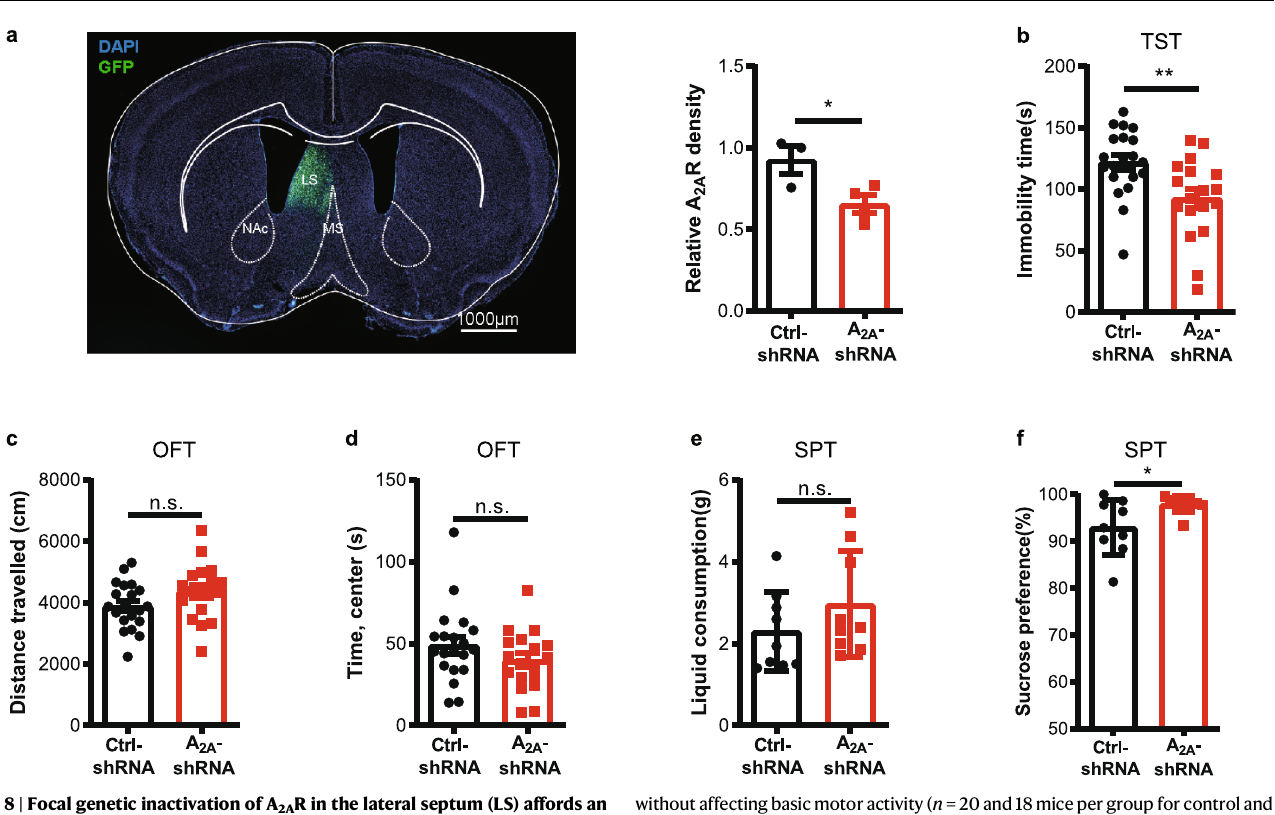
withoutaffectingbasicmotoractivity( n =20and18micepergroupforcontroland A 2A -shRNA, respectively. Unpaired t test, p =0.0860, t(36)=1.765) and time spent in the central area ( n =20 and 18 mice per group for control and A 2A -shRNA, respectively. Mann – Whitney test, p =0.1645, U=132) in the open fi eld test (OFT) ( c , d ). e , f Mice subject to LS-A 2A R knockdown displayed a similar total liquid consumption ( n =9 mice/group, Unpaired t test, p =0.2218, t(16)=1.271) but increased the consumption of sucrose compared with control mice ( n =9 mice/ group,Mann-Whitneytest, p =0.0400,U=17)inthesucrosepreferencetest(SPT). Datawereshownasmean±SEM.* p <0.05,** p <0.01;n.s.,nosigni fi cantdifference. Source data are provided as a Source Data fi